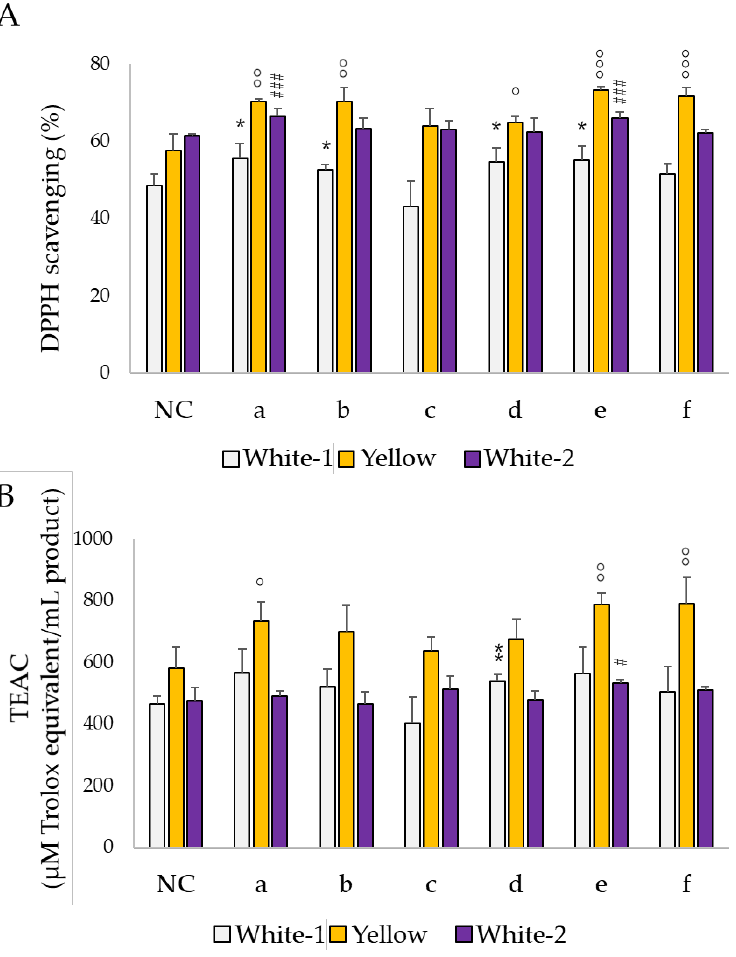
Figure 2. Antioxidant activity of different corn by-product extracts estimated with the DPPH ( A ) and ABTS ( B ) scavenging assays. These tests were carried out by spectrophotometric analysis: DPPH at 517 nm and the cation radical ABTS at 734 nm. In the latter test, the results were reported as Trolox equivalent antioxidant capacity (TEAC, µ M Trolox equivalent/mL product). The means of 3 experiments were compared with the specific control values (3 replicates for each experiment). Statistic symbol legend: *, °, and # are reported for white-1 , yellow, and white-2 corn by-products, respectively. (°°° , ### p < 0.001, ** , °° p < 0.01, * , ° , # p < 0.05).